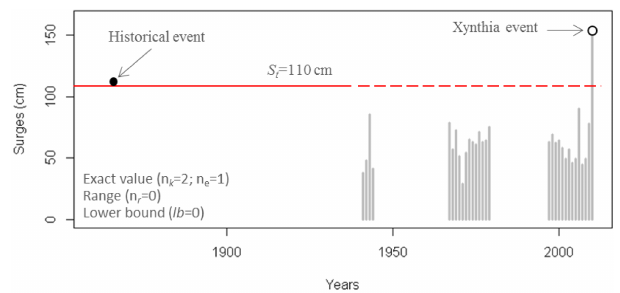
Figure 5. La Rochelle site – systematic and historical data and set- tings of the BMH frequency model.